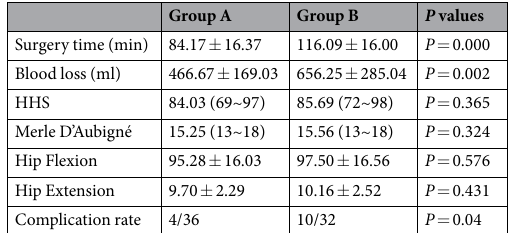
Table 1. Comparison of some indexes in two groups was presented.